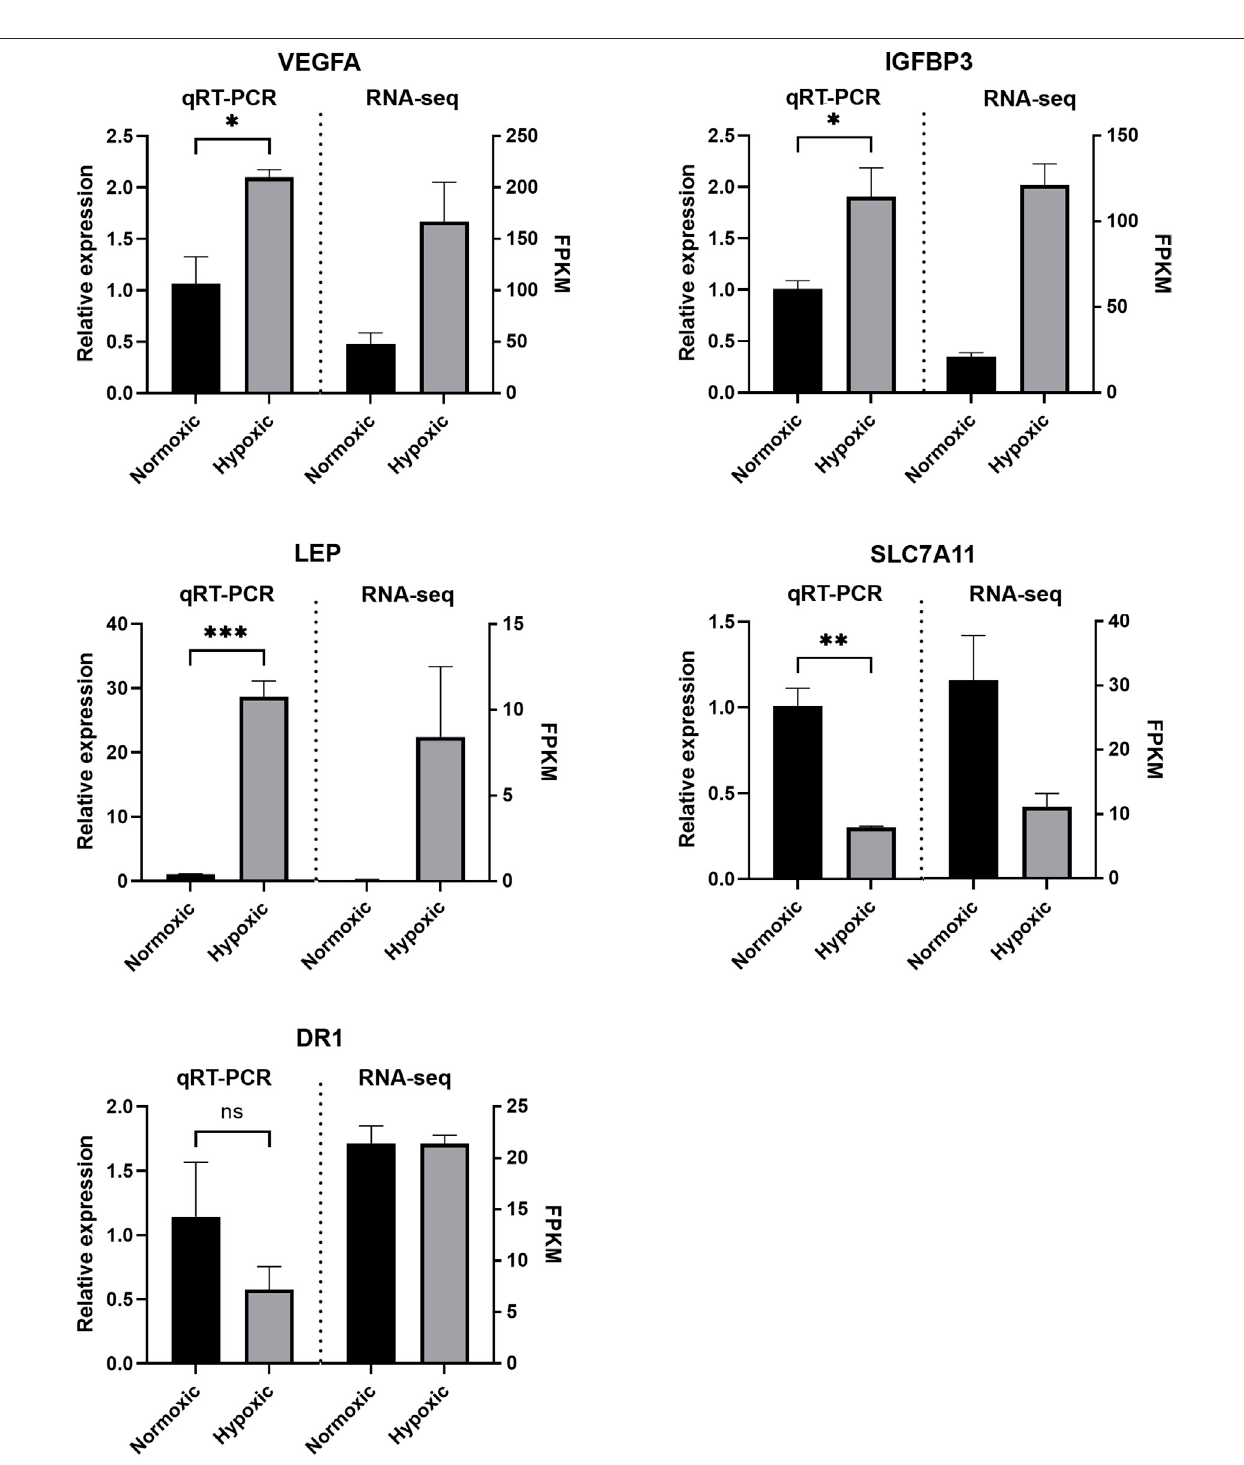
FIGURE7| ValidationoftheRNAsequencing(RNA-seq)data.Thequantitativereal-timePCR(qRT-PCR)resultsshowedthesametrendastheRNA-seqdata.The relativemRNA expression levelswerecalculatedusing the2 – ΔΔ Ct method afternormalization toGAPDH expression. Thedataareexpressed asmeans±SE.*, p < 0.05; **, p < 0.005; ***, p < 0.0005.